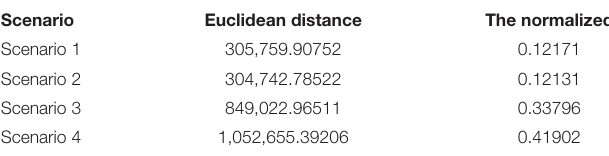
TABLE 7 | Euclidean distance between the two sets of